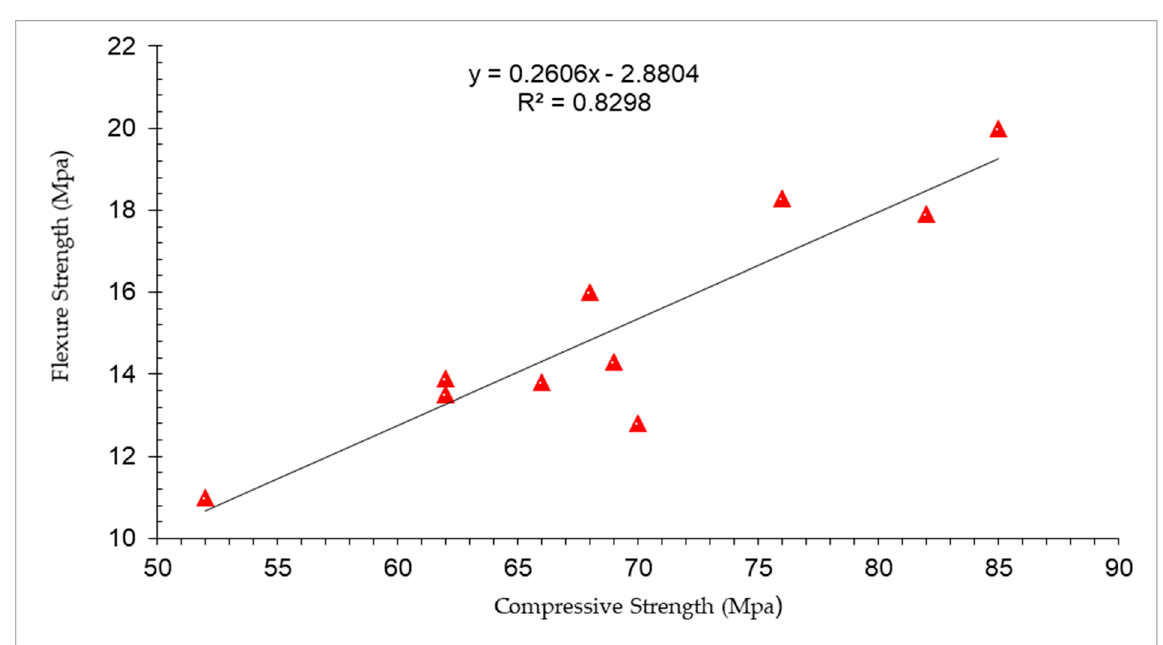
Figure 6. Flexure strength [55].